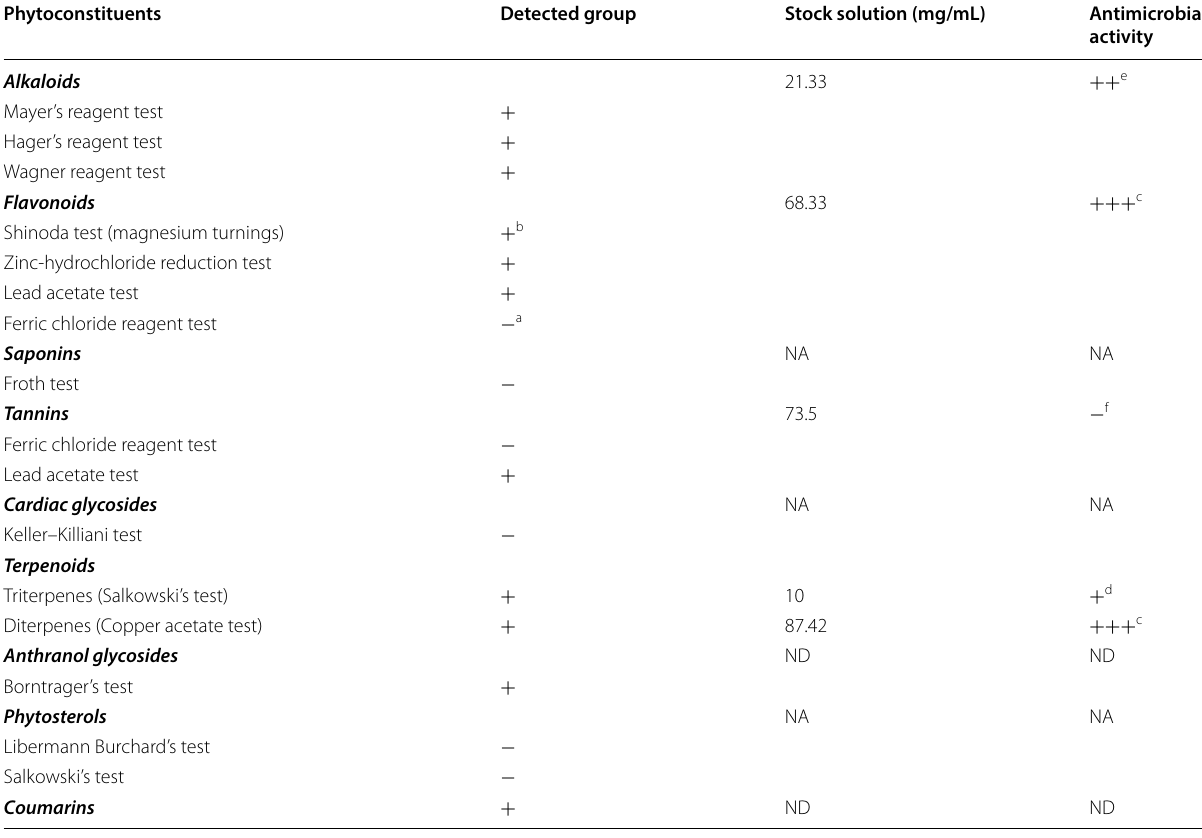
Table 2 Qualitative detection and antimicrobial activity of Berberis aristata root